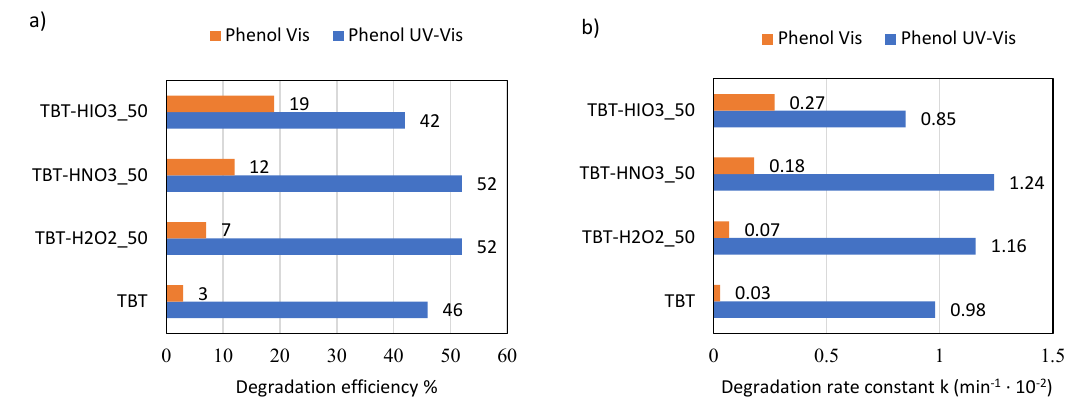
Figure 4. Efficiency of phenol degradation in UV-Vis and Vis light for TBT-TiO 2 and defective TiO 2 photocatalysts, presented as % of degradation ( a ) and rate constant k ( b ).